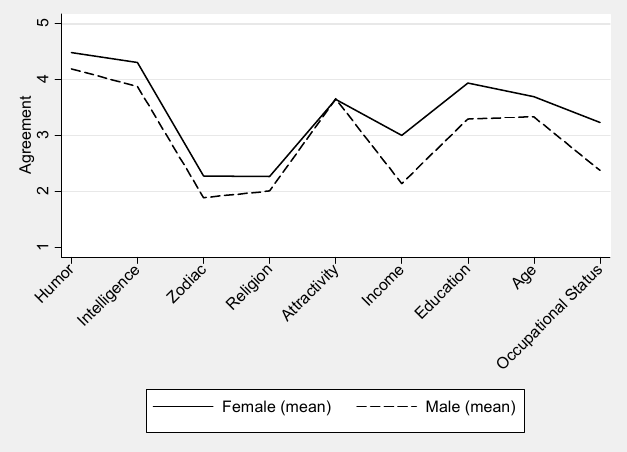
Figure 4 : Profile plot of subjective importance of several potential mate